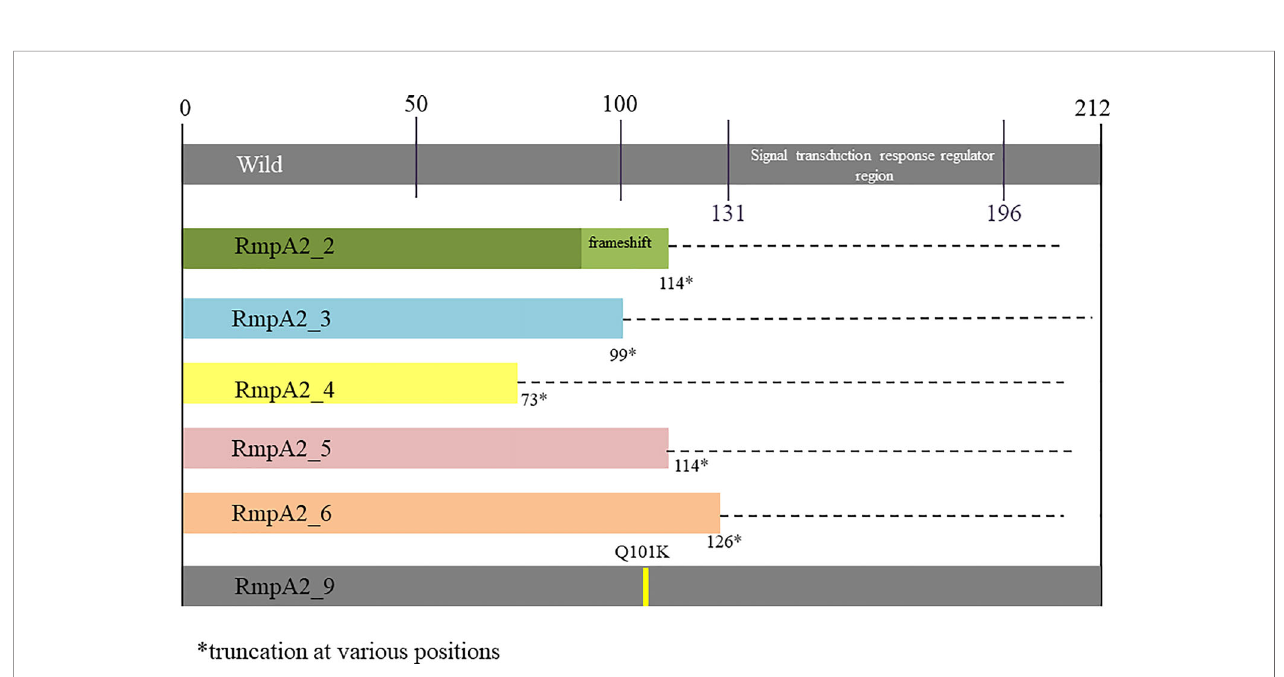
FIGURE 2 | Variants of RmpA2 observed among carbapenem resistant hypervirulent Kp from India..